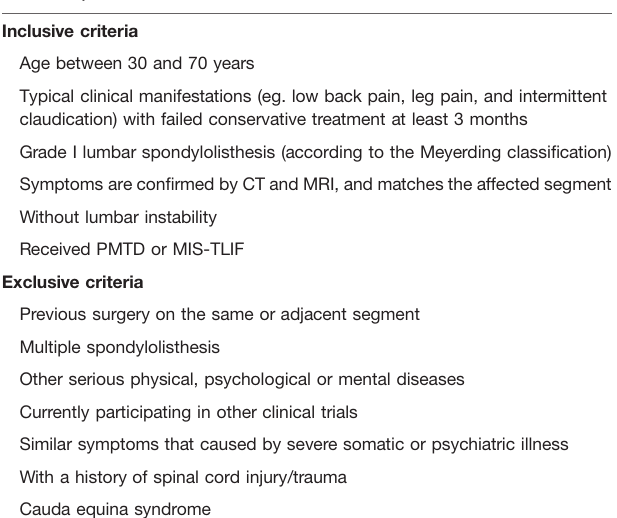
TABLE 1 | Inclusive and exclusive criteria.